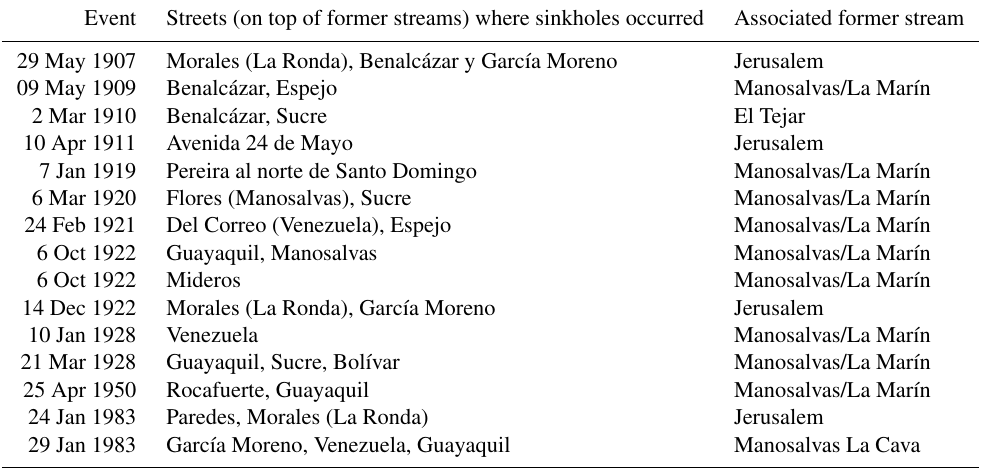
Table 2. Historical register of sinkholes and collapses. Event Streets (on top of former streams) where sinkholes occurred Associated former